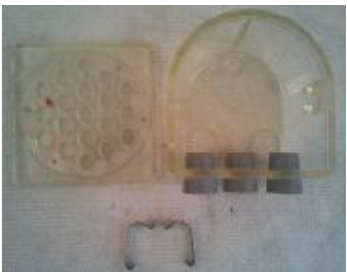
Figure 1: the parts of the plastic duplication flask which were used for cast duplication.